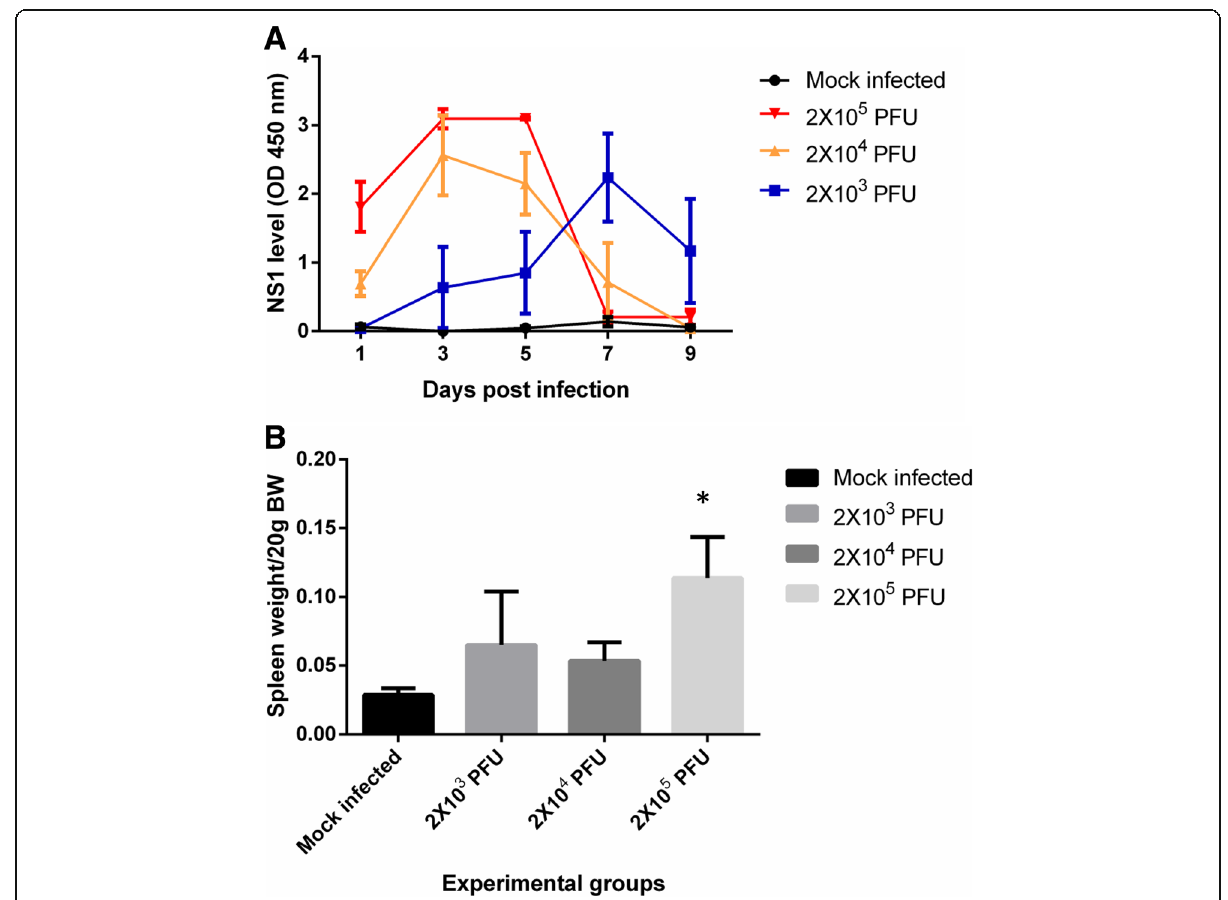
Fig. 1 The AG129 mice infected with non-adapted serotype 2 NGC strain dengue virus developed NS1 antigenemia and splenomegaly. AG129 mice intraperitoneally infected with 2 X 10 3 PFU or 2 X 10 4 PFU or 2 X 10 5 PFU of dengue virus strain NGC on Day 0 post infection. The mock infected mice group ( n =5) were inoculated with 200 μ l of media only. a The plasma NS1 level of mock infected (black circle) ( n =5) and infected ( n =5) (blue square: 2 X 10 3 PFU; yellow triangle: 2 X 10 4 PFU; red triangle: 2 X 10 5 PFU) AG129 mice groups were detected on day 1, 3, 5, 7 and 9 post infection by NS1 antigen immunoassay. Data represent mean values ± standard error of the mean (SEM). b The spleens of mock infected ( n =5) and infected ( n =5) AG129 mice groups were harvested and weighed on Day 11 post infection. Data represent mean values ± standard deviations (SD). The data comparison was done by using Tukey ’ s multiple comparison ANOVA. Statistical significance ( p <0.05) is depicted